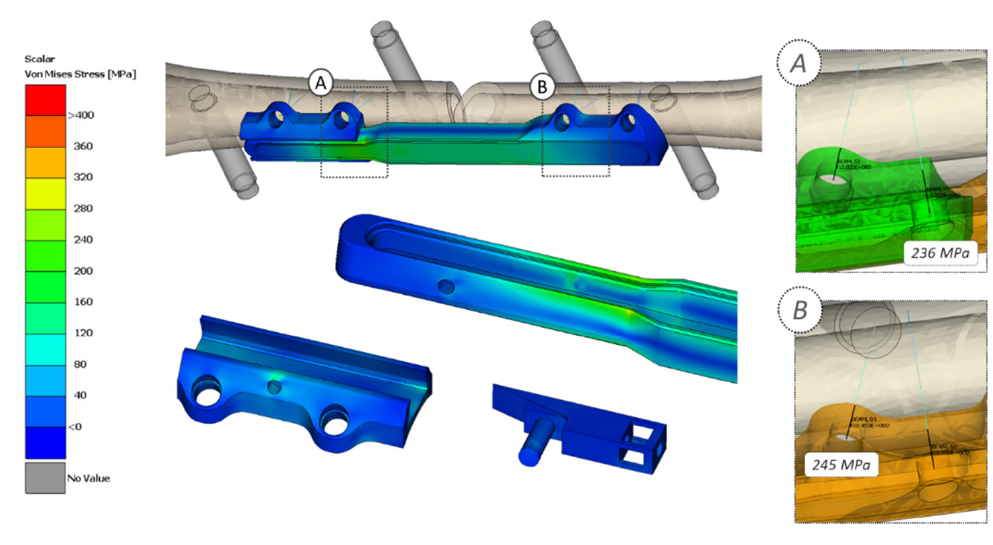
Figure 10. Maximum contact pressure at the experimental peak static load (2 kN): detail of plate components.